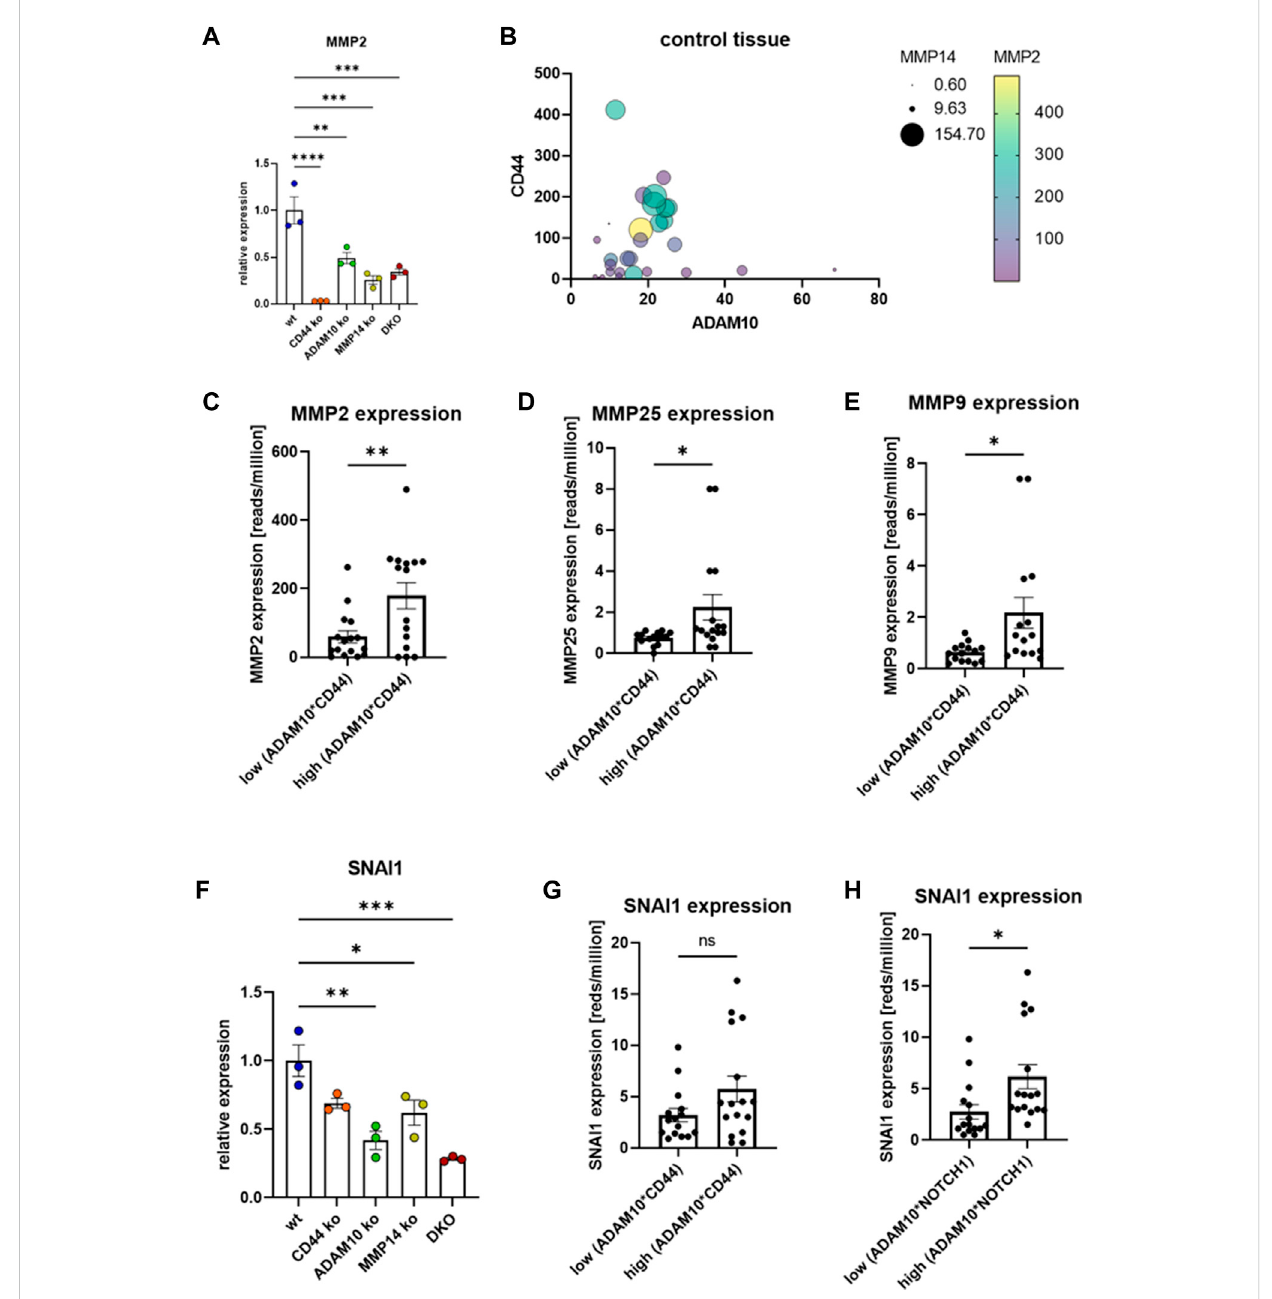
FIGURE 3 Transcriptional regulation of selected MMPs. (A) Transcriptional regulation of MMP2 in different CRISPR/Cas9 generated cell lines (n = 3, values are shown with SEM, one-way ANOVA). (B) Transcriptional regulation of MMP2 in dependency of CD44, ADAM10 and MMP14 analyzed in GTEx data. (C) Transcriptional regulation of MMP2 in dependency of ADAM10 and CD44 (n = 15 (lower median) and n = 16 (upper median), values shown as mean with SEM, unpaired Student ’ s t-test). (D) Transcriptional regulation of MMP25 in dependency of ADAM10 and CD44 (n = 15 (lower median) and n = 16 (upper median),valuesshownas meanwith SEM,unpairedStudent ’ st-test). (E) Transcriptional regulation ofMMP9 independency ofADAM10 andCD44 (n = 15 (lower median) and n = 16 (upper median), values shown as mean with SEM, unpaired Student ’ s t-test). (F) The expression of SNAI1 is signi fi cantly reduced in cells de fi cient for MMP14, ADAM10 or both proteases (n = 3, values are shown with SEM, one-way ANOVA). (G) The expression of SNAI1 does not depend on the expression of ADAM10/CD44 (n = 15 (lower median) and n = 16 (upper median), values shown as mean with SEM, unpaired Student ’ s t-test). (H) TheexpressionofSNAI1differssigni fi cantlywhensortedbytheexpressionlevelofADAM10*NOTCH1(n=15(lowermedian)andn=16(upper median), values shown as mean with SEM, unpaired Student ’ s t-test). * p < 0.05, ** p < 0.01, *** p < 0.001 **** p <